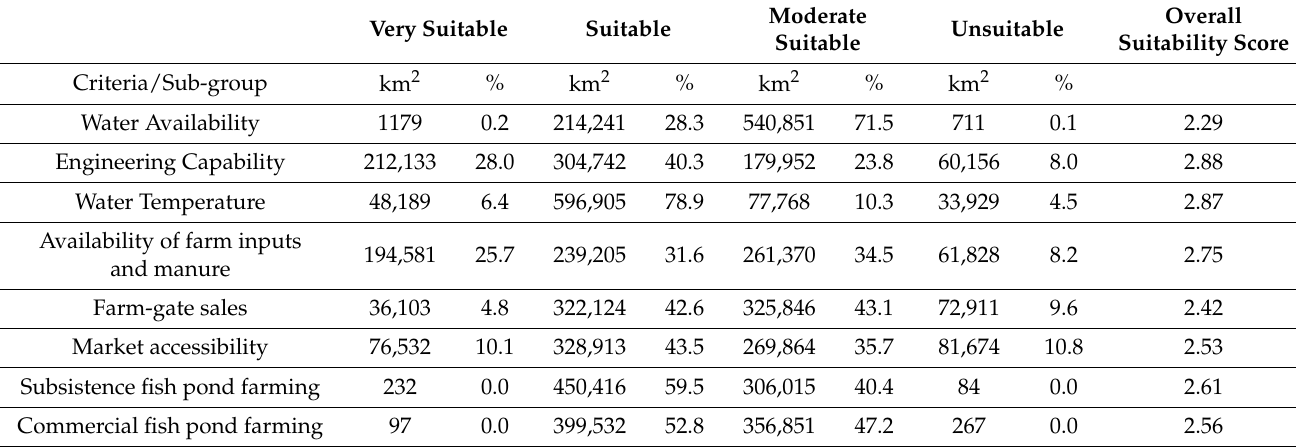
Table 5. Distribution of suitability scores for small-scale subsistence and commercial fish pond farming in mainland Tanzania and for criteria of importance to these activities.